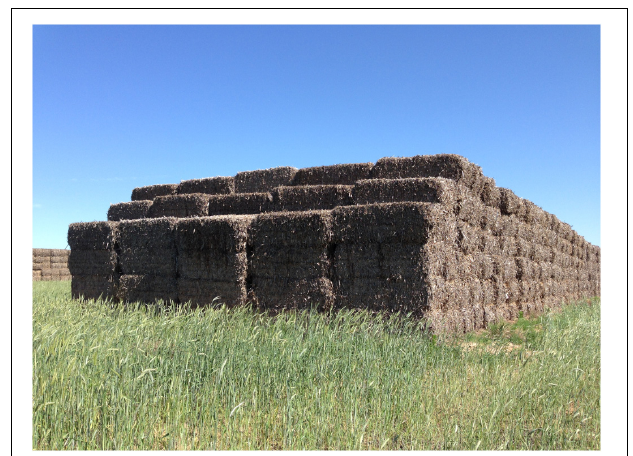
FIGURE 6 | Corn stover bale stack at a satellite storage